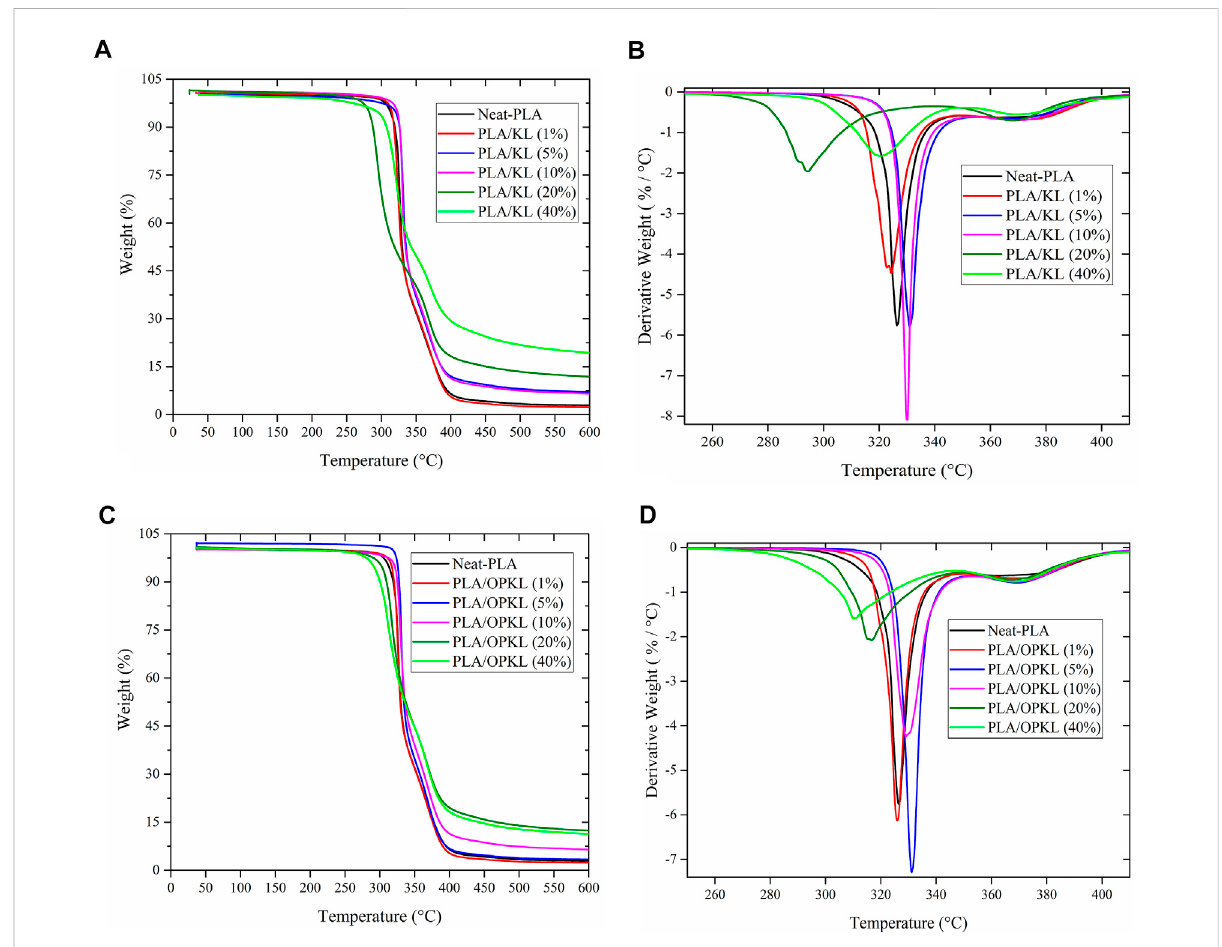
FIGURE 3 TG and the corresponding DTG curves of (A,B) PLA/KL and (C,D) PLA/OPKL composites